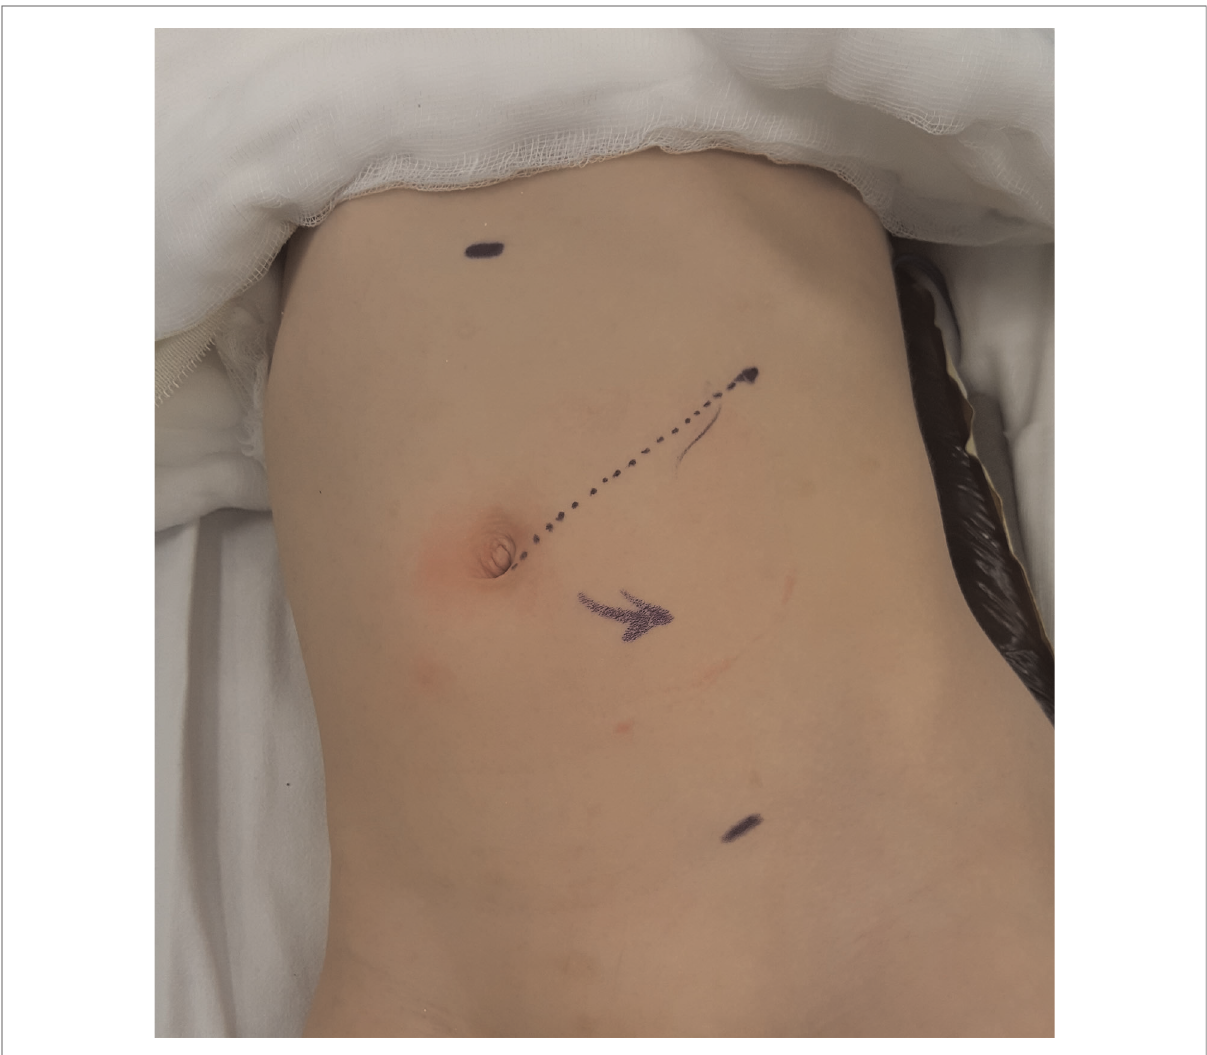
FIGURE 1 Our typical port sites for left-sided RALP with the camera port at infraumbilical ring and two 8-mm working ports at epigastrium and left iliac fossa mid-clavicular